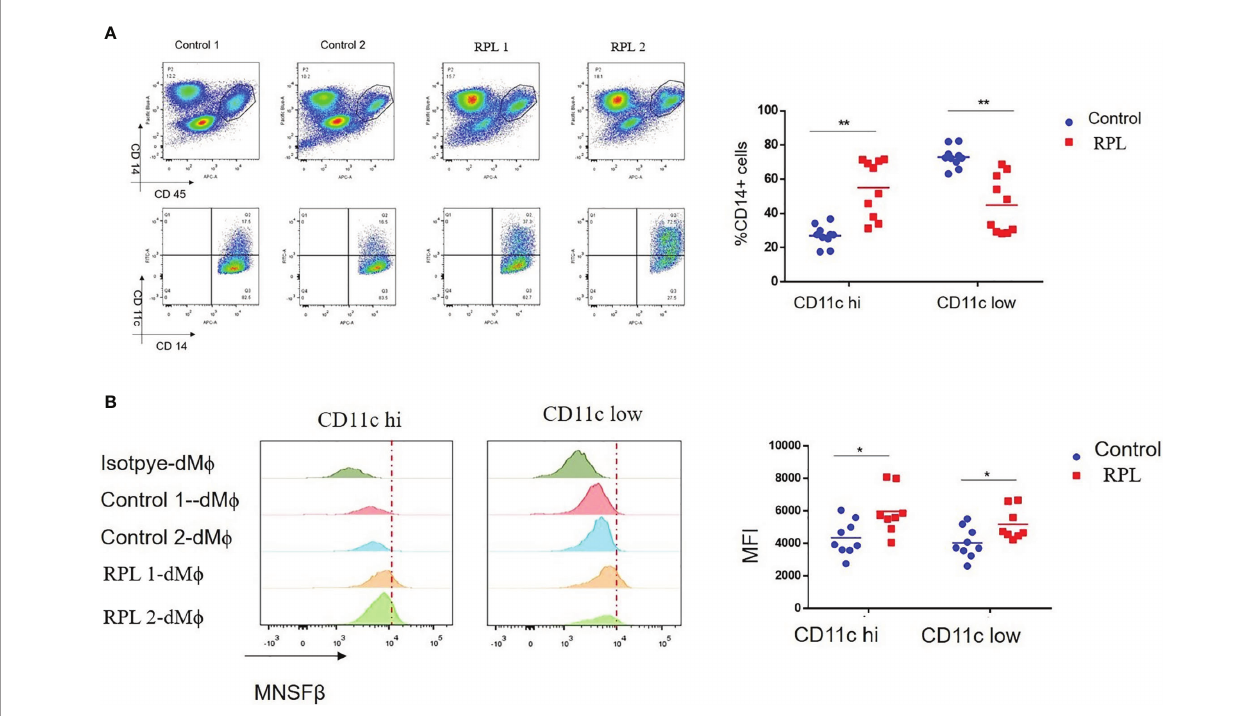
FIGURE 3 | Changes in the proportion of the CD11c high and CD11c low subsets in human dM f from RPL patients. (A) Proportion of the CD11c high (CD11c hi) and CD11c low (CD11c low) subsets in the dM f of Control women ( n = 9) and RPL patients ( n = 8) as detected by fl ow cytometry. Left panel: fl ow cytometry analysis of dM f with antibodies against CD45 plus CD14 and CD14 plus CD11c. Right panel: Proportions of CD11c hi and CD11c low dM f . (B) MNSF b protein expression levels in CD11c hi and CD11c low dM f from Control women ( n = 9) and RPL patients ( n = 8) as detected by fl ow cytometry. Left panel: Representative images of the fl ow cytometry assay; right panel: the mean fl uorescence intensity (MFI) of MNSF b as detected by fl ow cytometry. (Control: dM f isolated from decidual tissues of normal women in early pregnancy; RPL: dM f isolated from decidual tissues of RPL patients, * p < 0.05, ** p <